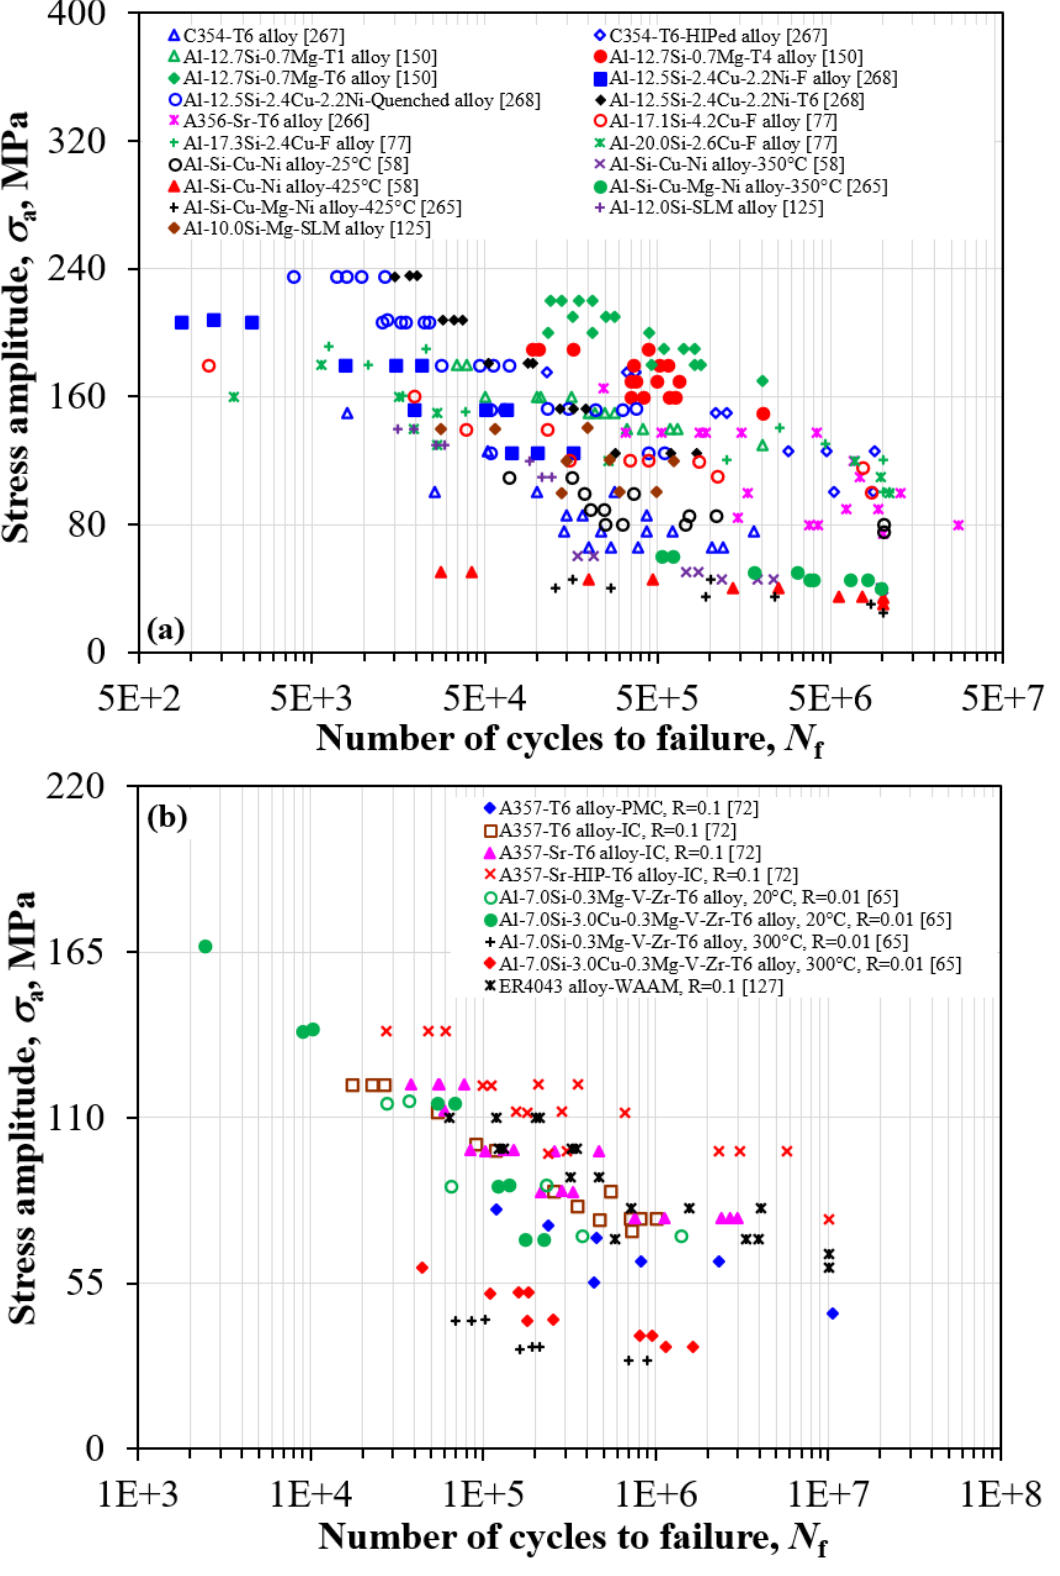
Figure 12. Stress amplitude vs. the number of cycles to failure ( N f ) plots tested under HCF at a stress ratio of ( a ) R σ = − 1 and ( b ) R σ (cid:54) = − 1